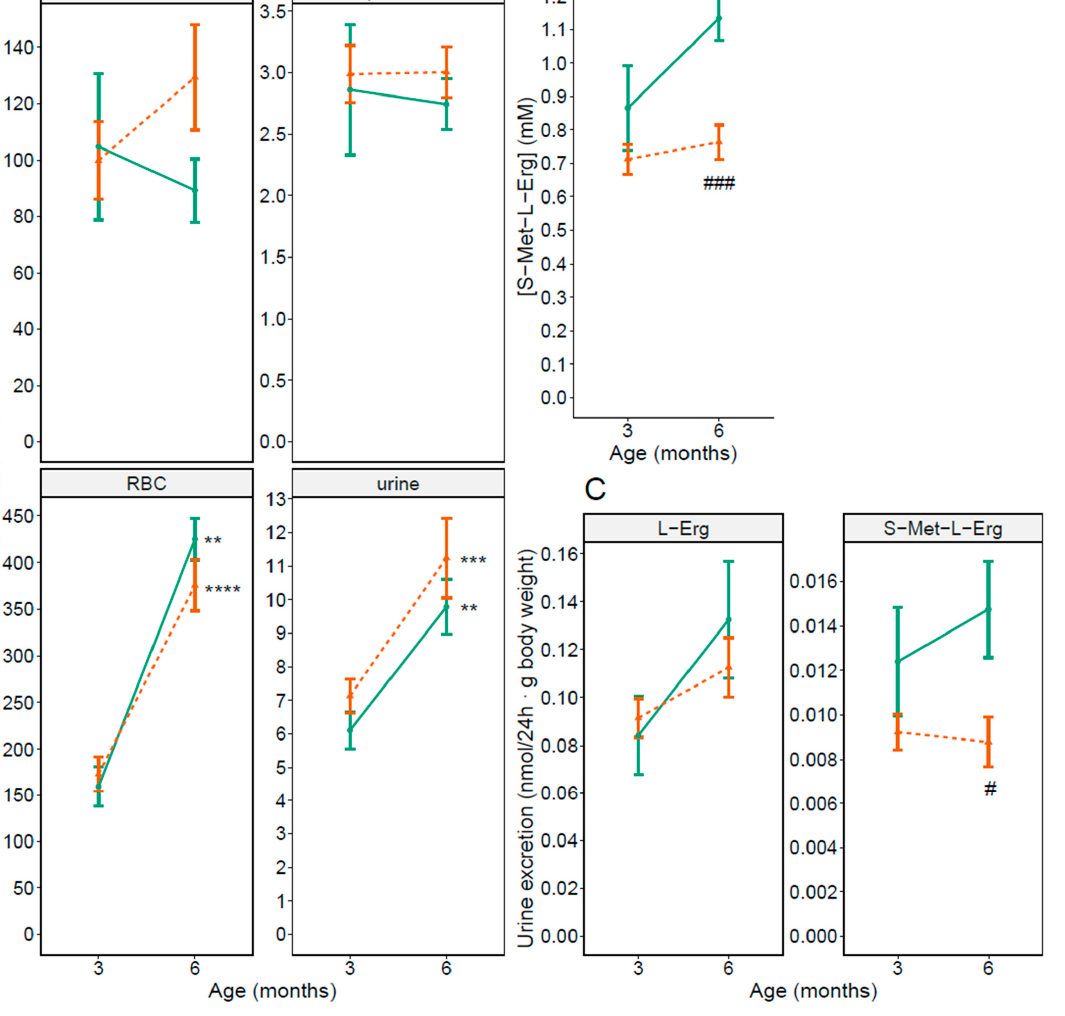
Figure 1. L-Erg and S-Met-L-Erg levels in WT and cystinuric ( Slc7a9 − / − ) male mice at 3 and 6 months of age. ( A ) L-Erg concentration in blood, plasma, red blood cells (RBC) and 24 h urine in WT (green solid line) and Slc7a9 − / − (orange dashed line) male mice. ( B ) S-Met-L-Erg concentration in 24 h urine. ( C ) L-Erg and S-Met-L-Erg excretion. In all panels, mean ± SEM are shown and Mann-Whitney probability test value are indicated as **, p ≤ 0.01; ***, p ≤ 0.001 and ****, p ≤ 0.0001 vs. 3 months of age; #, p ≤ 0.05 and ###, p ≤ 0.001 vs . WT mice. The number of independent mice used per condition ranges from 5 to 30.